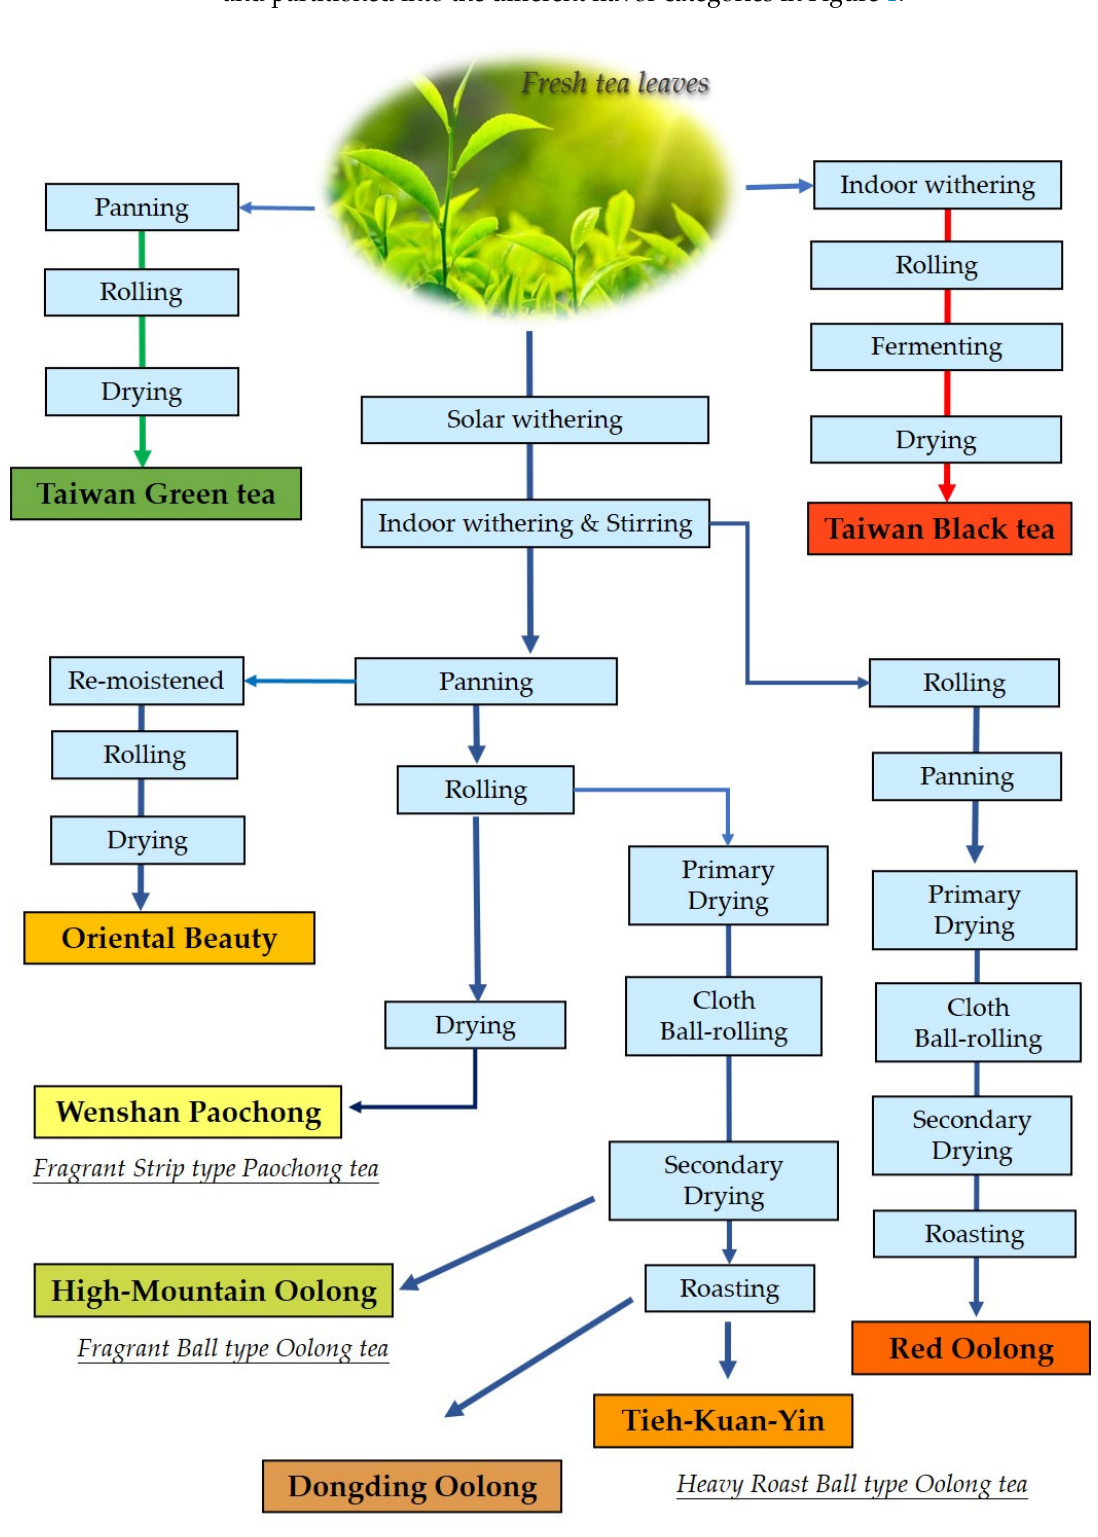
Figure 1. The manufacturing processes and flavor categories of eight specialty teas in Taiwan. The flavors of Dongding Oolong, Tieh-Kuan-Yin, and Red Oolong are assigned to the flavor category of heavy roast ball-type Oolong tea (HRBOT).